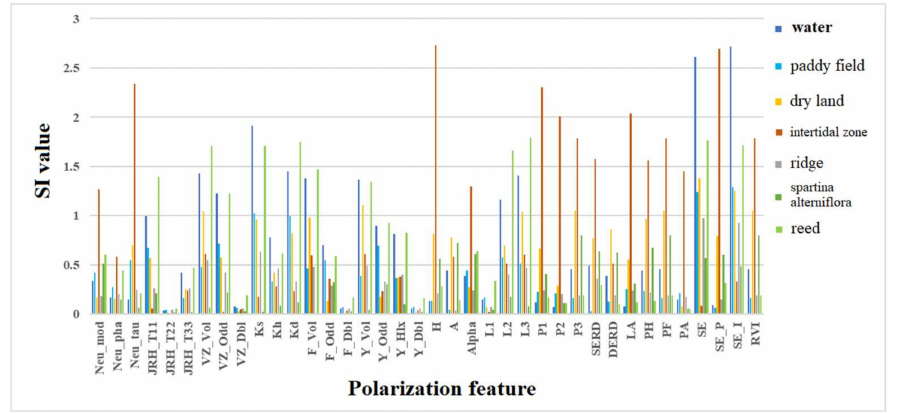
Figure 3. Bar chart between SI value and characteristics of Yancheng coastal